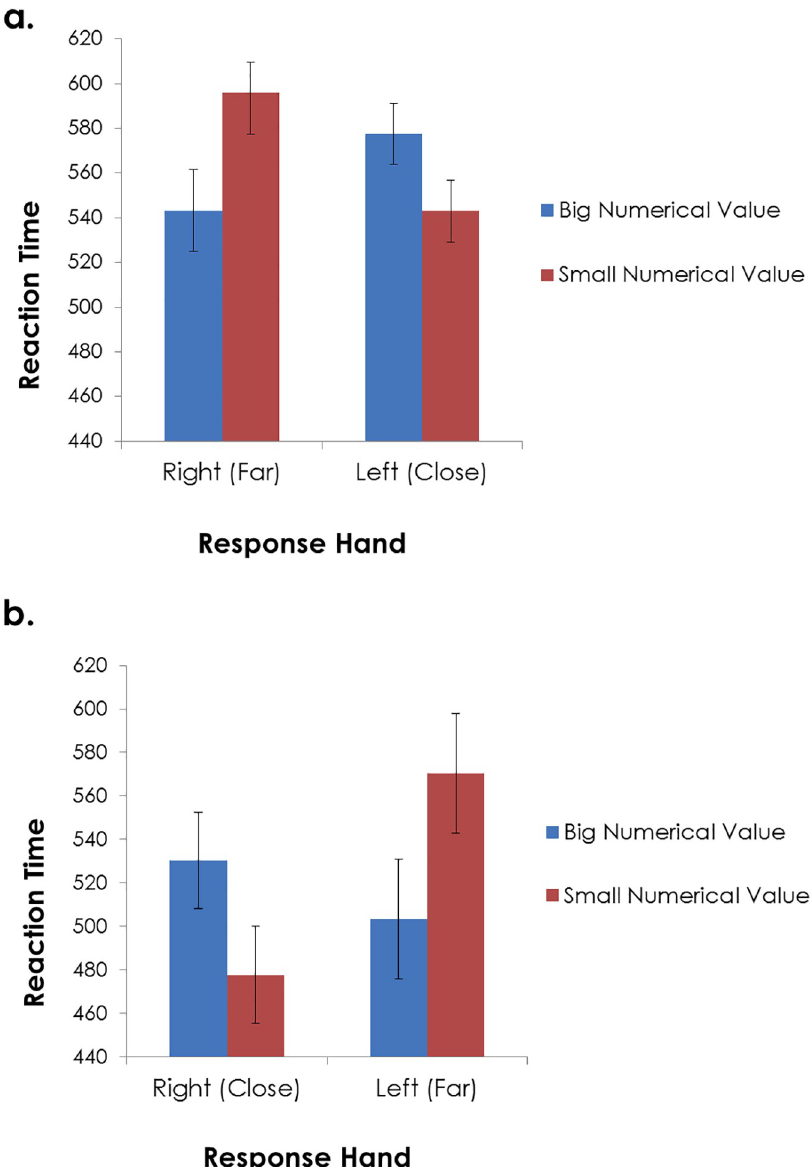
Fig 2. Reaction times in Experiment 1, as a function of response hand and numerical value, within each of the hand-position groups. In one group, the right hand was positionedon the far key and the left hand was positioned on the close key (a), whilein the other group responsekeys were flipped(b). Standard errors are computedfor the difference score (betweenbig and small numerical values) [19], within each of the responsehand